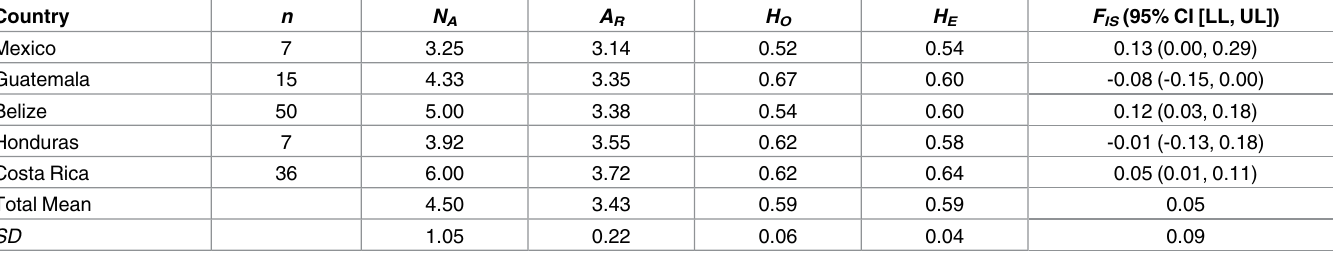
Table 2. Summary statistics of genetic diversity for Mesoamerican jaguars.